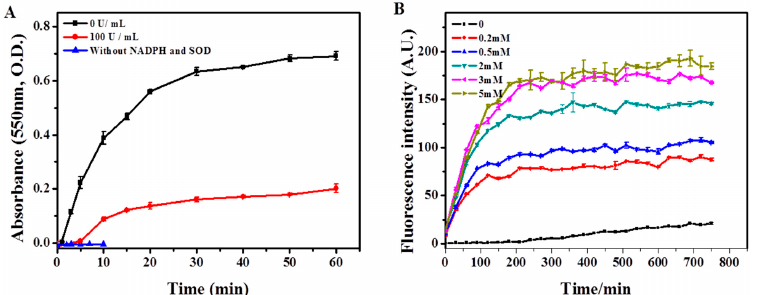
Figure 5. Construction of the in vitro respiratory burst enzymatic system, as evaluated through the generation of O 2 * − and H 2 O 2 . ( A ) The generation of O 2 * − by NOX solution over time in the presence or absence of SOD, as measured by ferrocytochrome c absorbance at 550 nm; ( B ) The production of H 2 O 2 over time by NOX and SOD catalyses, in the presence of different concentrations (0–5 mM) of NADPH, as measured by the fluorimetric hydrogen peroxide assay.The data demonstrated that NOX was viable to produce O 2 * − , which was then converted to H 2 O 2 by SOD. The nanotubes were previously shown to be degraded by hMPO in the presence of H 2 O 2 [35,37,61]. hMPO can catalyze the production of even stronger oxidizing substances such as Int. J. Mol. Sci. 2016 , 17 , 409 hypohalous acids in the presence of sodium chloride (NaCl) to degrade internalized particles and bacteria [44]. We therefore incubated SWCNTs in the in vitro enzymatic system with the addition of NaCl, and at different time points (8, 24, and 30 h) we sampled the SWCNTs to track the degradation process of SWCNTs. As shown in Figure 6, for p-SWCNTs, the Raman spectra have little or no change in the D-band and G-band intensity in MPO only, full enzyme solution (MPO + SOD + NOX) and NAC (MPO + SOD + NOX + NAC) groups, which means there is nearly no oxidation on p-SWCNTs. As for ox-SWCNTs and OH-SWCNTs, MPO alone caused no change in the Raman spectra, but in full enzyme solution, both types of SWCNTs exhibited the tendency of degradation as I D /I G ratios increased with time (Figure 6, ox-SWCNTs, OH-SWCNTs), to 0.67 (±0.05) and 0.85 (±0.04) for ox- SWCNTs at 24 and 30 h, respectively, and to 0.76 (±0.04) and 0.93 (±0.06) for OH-SWCNTs at 24 and 30 h, respectively, suggesting that defect sites of SWCNTs increased and the structure of nanotubes were damaged. However, the degradation process could be suppressed by the addition of NAC to the full enzyme solution, as shown in Figure 6 (MPO + SOD + NOX + NAC group), proving that SWCNT biodegradation induced by respiratory burst could be completely inhibited (OH-SWCNTs) or alleviated (ox-SWCNTs) by anti-oxidants that scavenge the ROS. We further used UV-vis-NIR spectroscopy to assess the degradation of SWCNTs after 24 and 30 h incubation with enzyme solutions (Figure 7). Very similar to the results obtained from Raman spectrum analyses, we found essentially no change in the absorbance of S 2 band of p-SWCNTs (Figure 7, pristine-SWCNTs). However, both ox-SWCNTs and OH-SWCNTs showed a significant decrease of the absorbance of S 2 band in a time-dependent manner after being incubated with full enzyme solution, whereas the addition of NAC significantly inhibited the degradation process, with the peak area of S 2 band back to the level comparable to that of MPO alone group (Figure 7C).